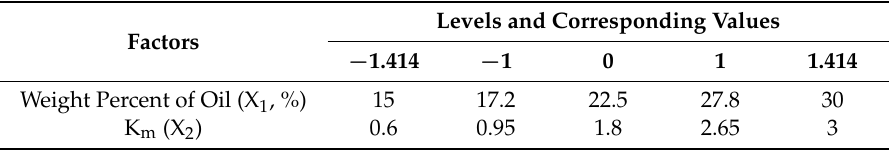
Table 1. Level codes of factors and corresponding values in central composite design.